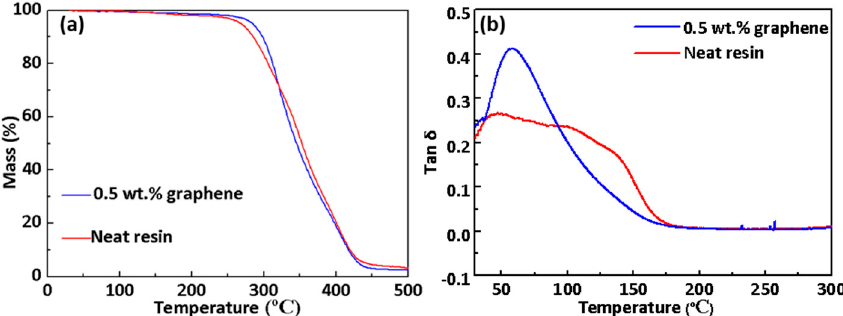
Figure 5. ( a ) Thermalgravimetric analysis (TGA) and ( b ) dynamic mechanical analysis (DMA) curves of UV-cured resin with or without graphene.